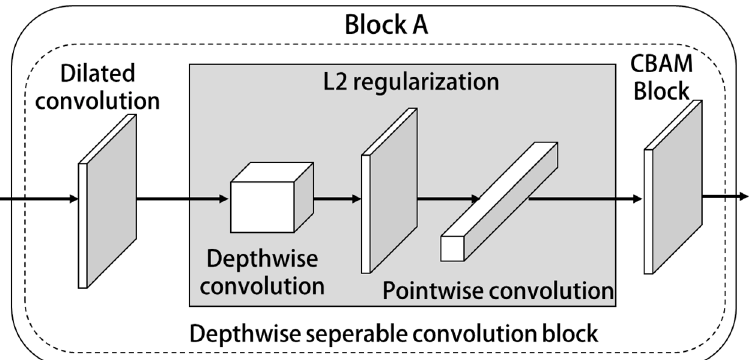
Figure 2. Block A structure. Figure 2. Block A